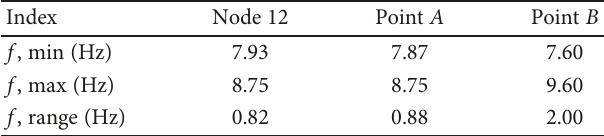
Table 11: D5, excitation far from the damage, localization indexes. Index Node